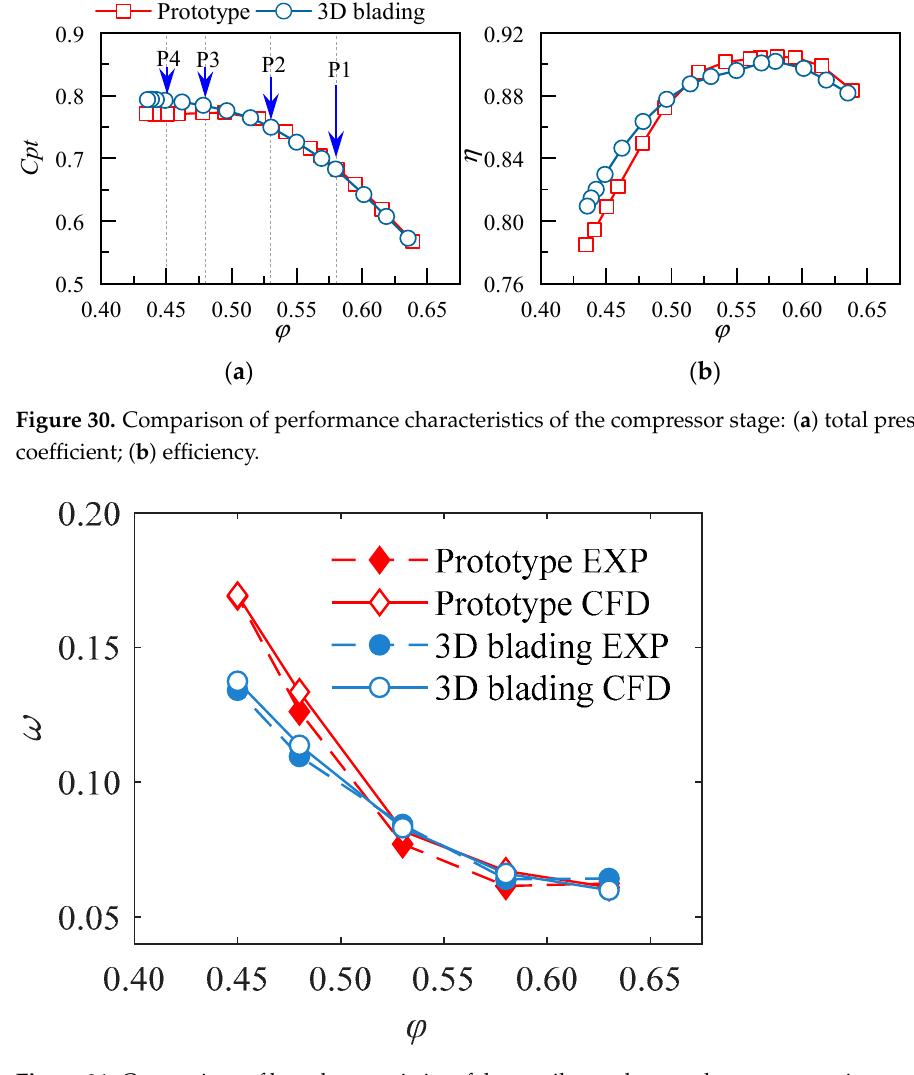
Figure 31. Comparison of loss characteristics of the cantilevered stators between experiment and CFD.